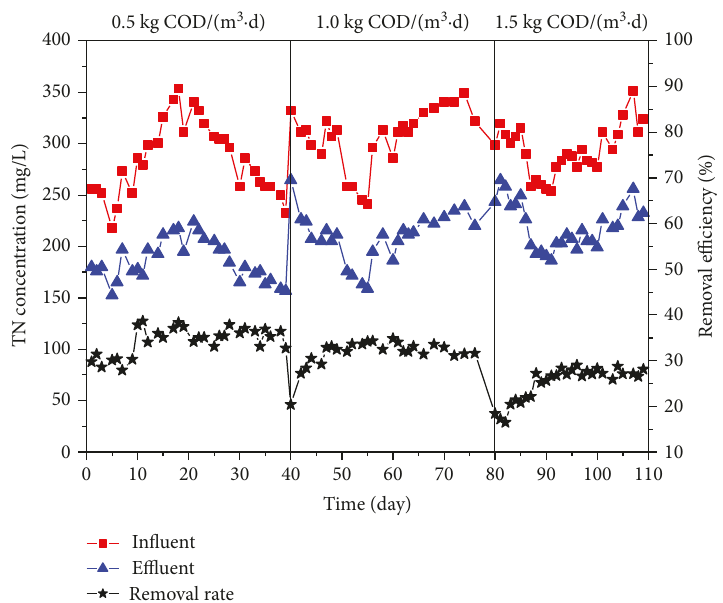
Figure 4: TN concentration variations in in fl uent and e ffl uent.